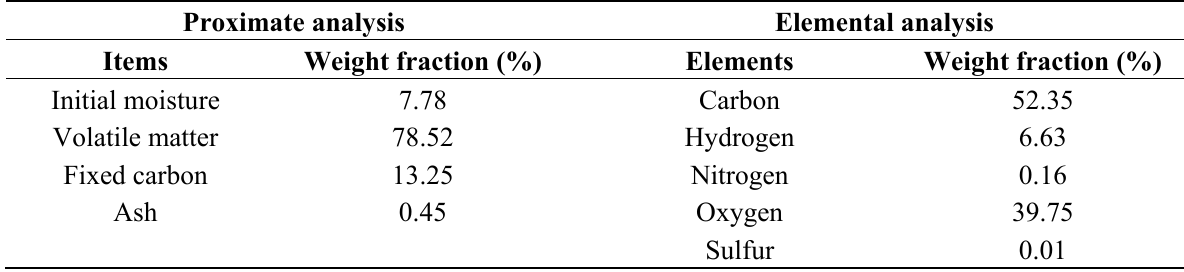
Table 1. Proximate and elemental analyses of wood sample used in this